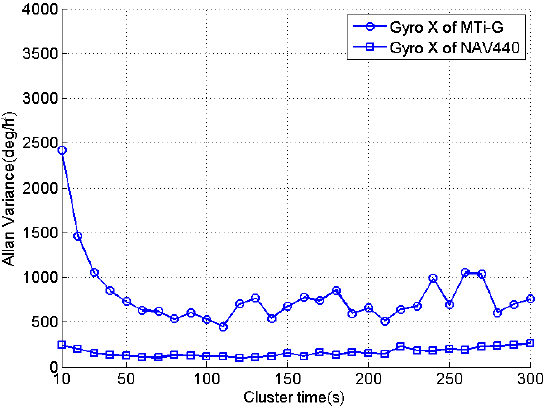
Figure 6. Allan variances of gyro data in X-axis for MTi-G and NAV440.